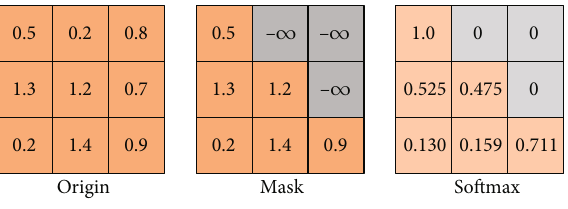
Figure 5: Masking